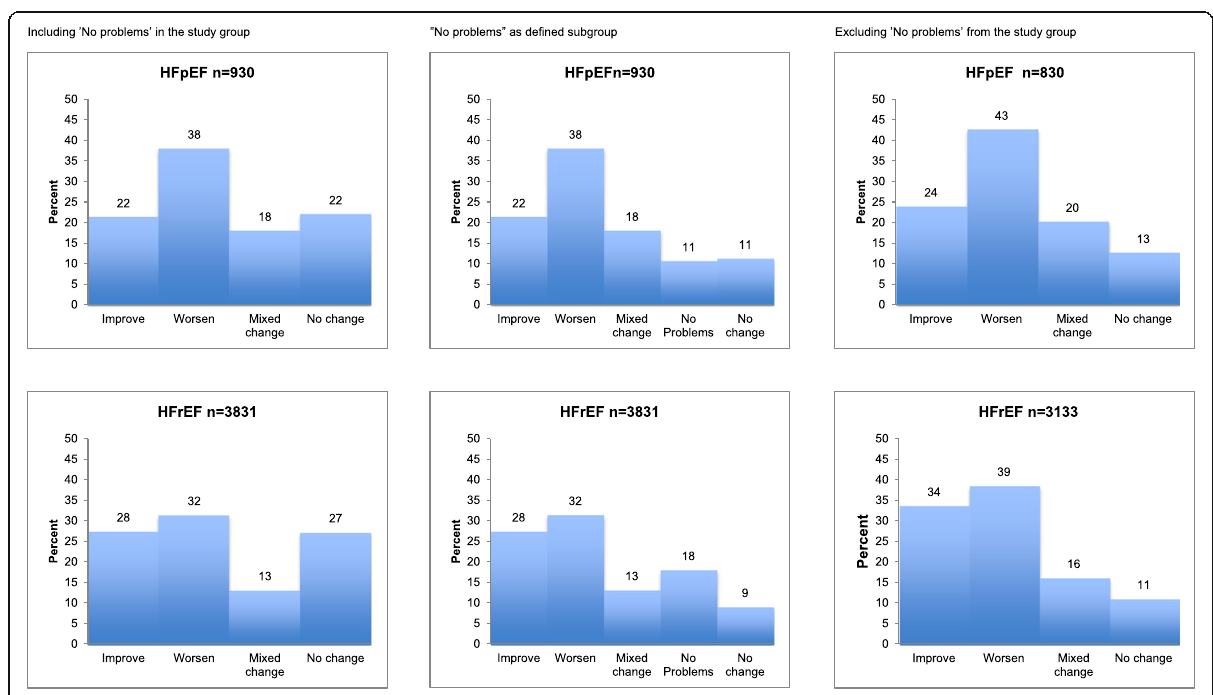
Fig. 3 Proportions of patients in the two groups HFpEF (EF > 50%) and HFrEF (EF < 40%) in different groups of Paretian Classification of Health Change as measured by the